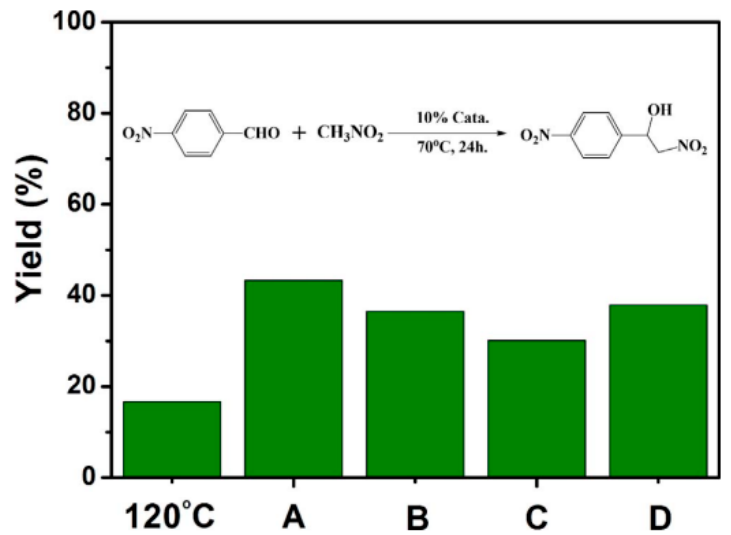
Figure 2. Twenty-four-hour yield of the Henry reaction of 4-nitrobenzaldehyde with nitromethane catalyzed by Cu-BTC_X: 120 ◦ C corresponds to conventional microporous Cu-BTC; A (Cu-BTC_A); B (Cu-BTC_B); C (Cu-BTC_C); D (Cu-BTC_D) in which A, B, C and represents aniline, 2- dimethylaminoethylamine, hexylamine and N,N,N ′ ,N ′ -tetramethylethylenediamine as templates for the preparation of hierarchical MOFs. Reprinted with permission from [39]. Copyright (2018) Elsevier.